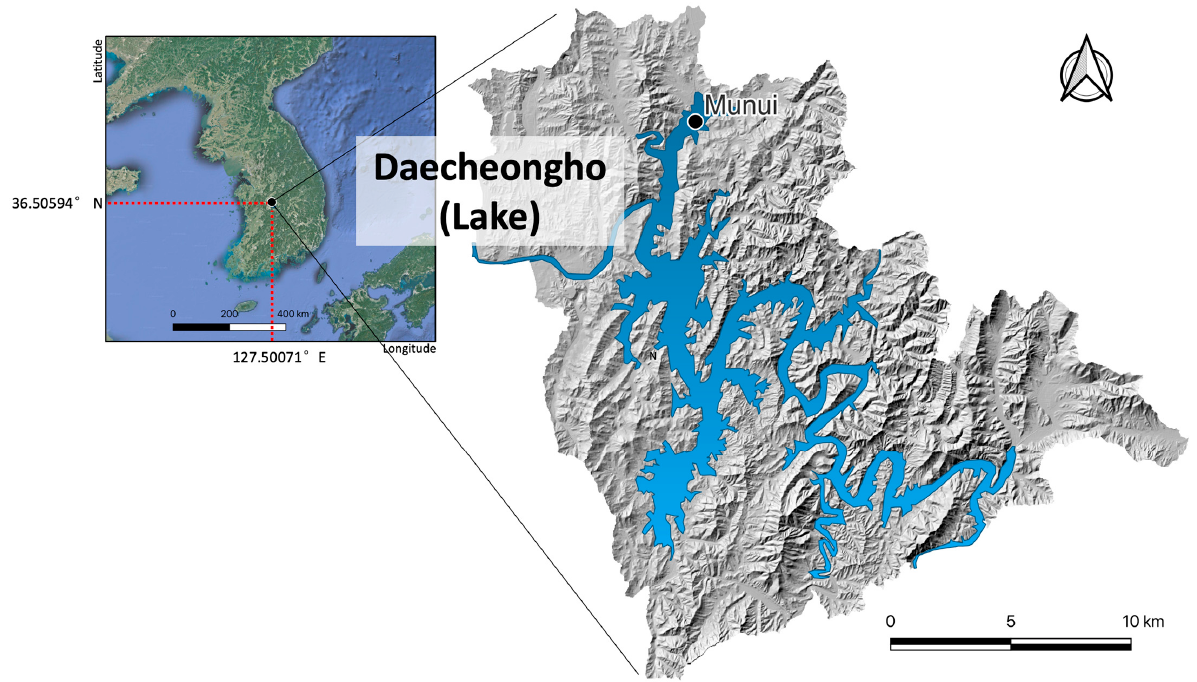
Figure 1. Survey site at Munui in an inlet area of Daecheongho (a lake in South